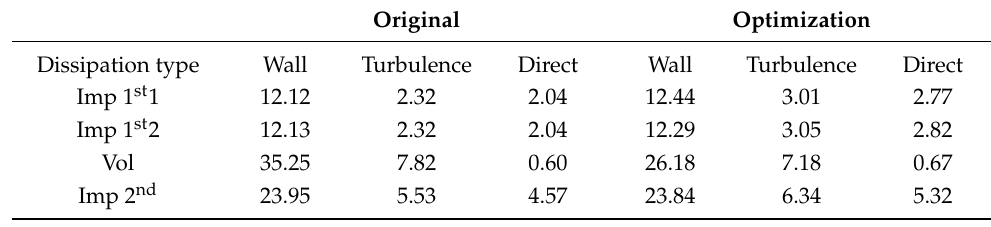
Table 8. Entropy production for the wall, turbulence, and direct dissipation of different components before and after optimization. Original Optimization